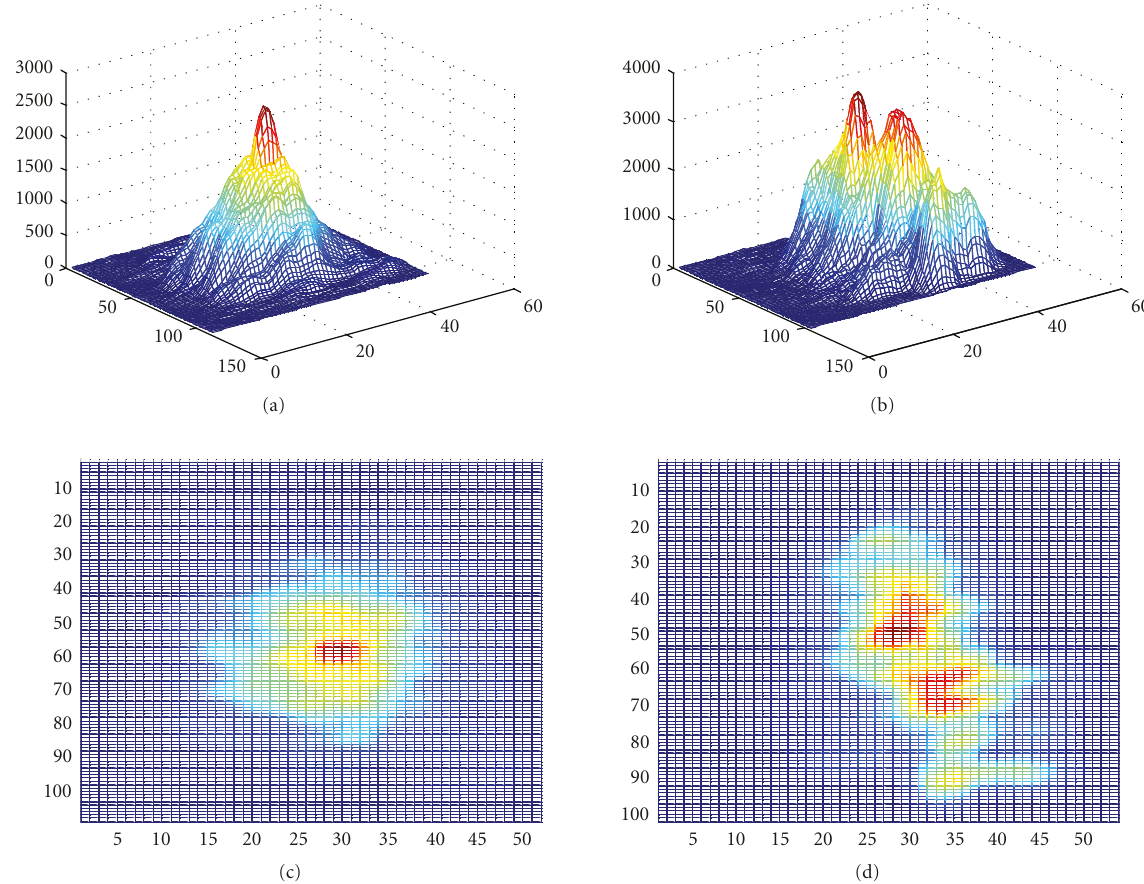
Figure 3: (a) The voting space histogram of the reference point related to the first frame (Frame #536) of the sequence that appears in Figure 11; (b) the voting space histogram related to Frame #570 of the same sequence, (c)–(a) from a top view, and (d)–(b) from a top